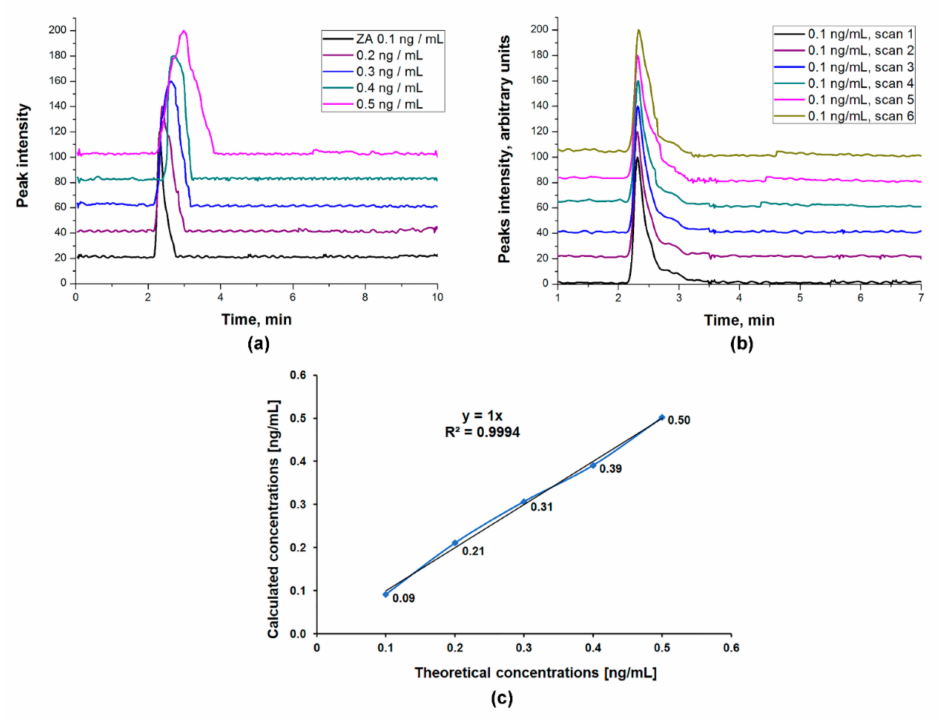
Figure 5. Linearity of the HPLC-ESI-MS method: ( a ) Chromatograms recorded for standard curve concentrations; ( b ) Chromatograms recorded for the 6 injection scans of 0.1 ng ZA/mL; ( c ) Linearity plot for ZA